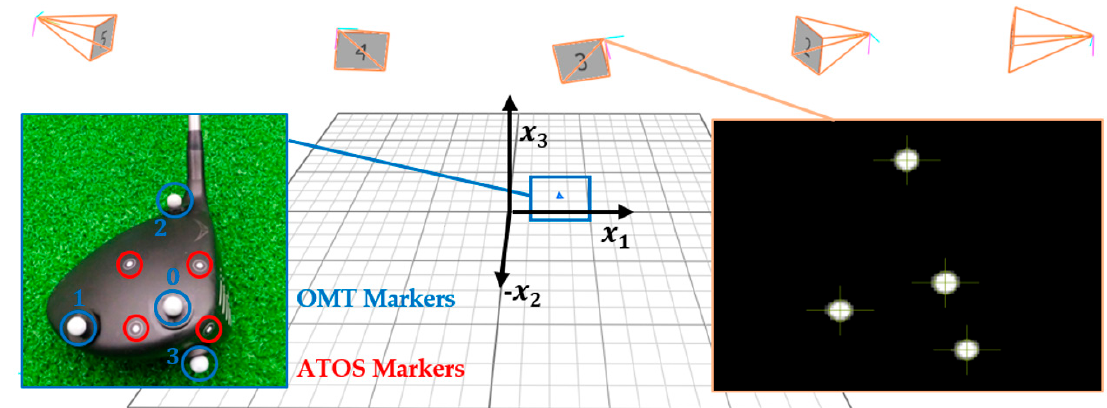
Figure 1. Marker reconstruction in optical marker tracking (OMT). ( left ) Physical OMT markers (0–3) on the clubhead. ( right ) Camera image of grayscale blobs with fitted centroids. Middle: Triangulation of the marker centroids from all cameras for reconstruction in three-dimensional space. Flat markers required for reference measurements with optical metrology system